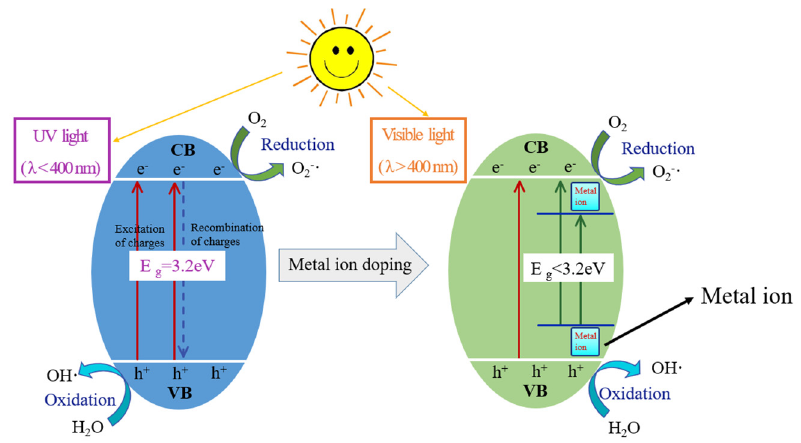
Figure 4. The mechanism of metal ion doping TiO 2 .